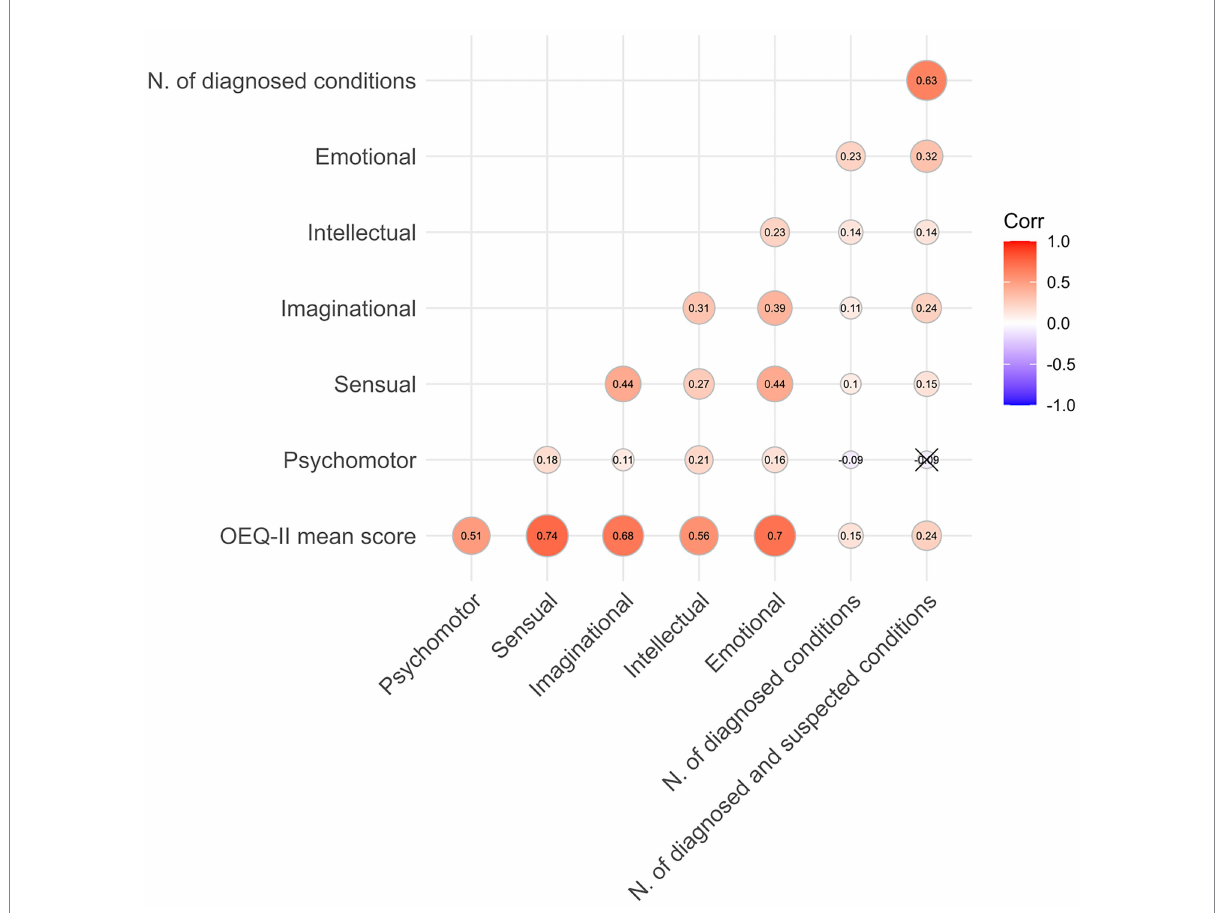
FIGURE 4 Correlation heatmap for bivariate Spearman correlations of the number of physiological and psychological overexcitabilities and factor scores from the